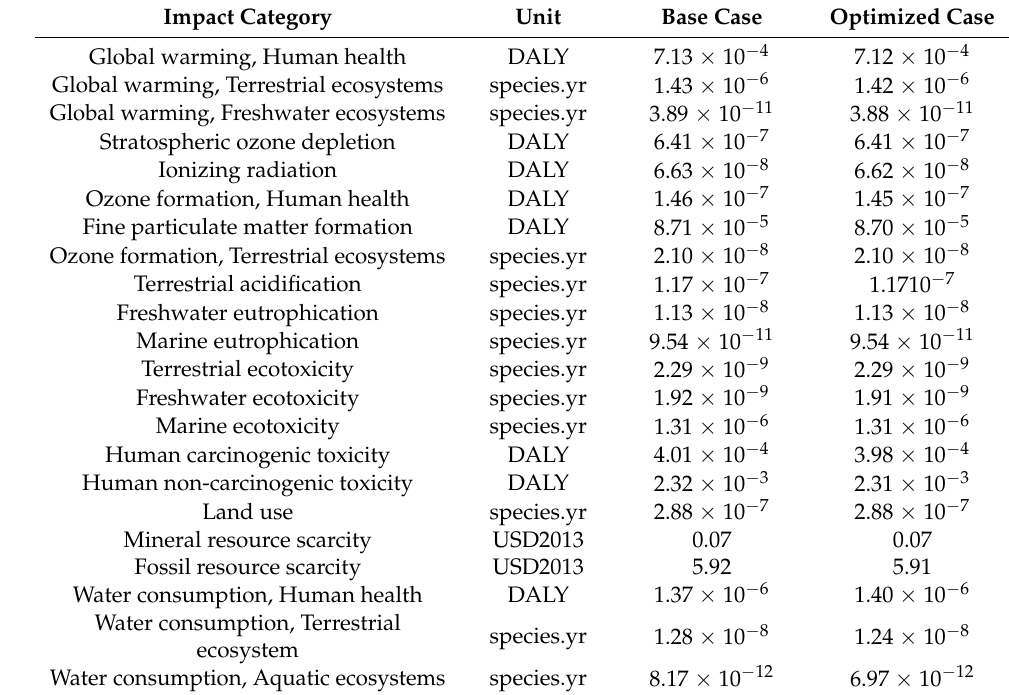
Table 4. Environmental impacts of chitosan process alternatives based on ReCiPe End-point